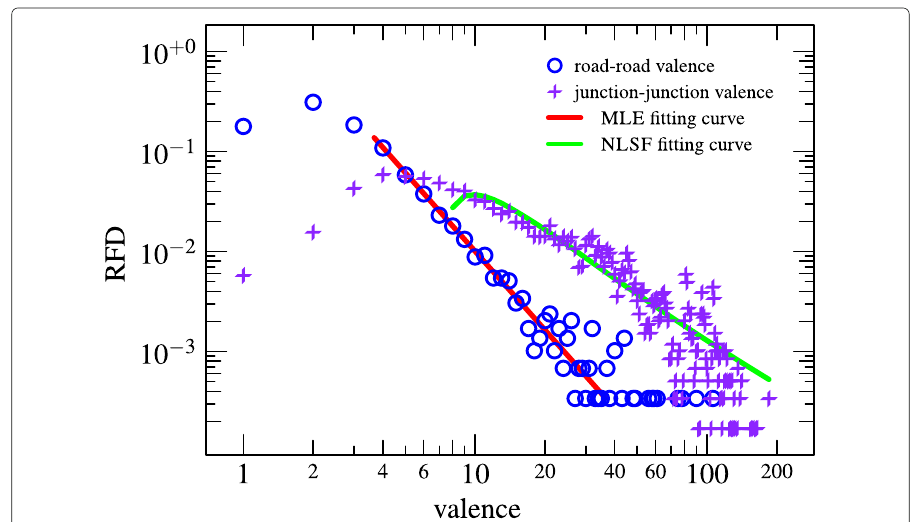
Fig. 4 Relative Frequency Distributions (RFD) for the urban street network of Central London: circles represent relative frequencies for the valences of the road-road topological network; crosses represent relative frequencies for the valences of the junction-junction topological network. The red fitted curve for the natural road statistics describes the Maximum Likelihood Estimate (MLE) for the discrete Pareto probability distribution (14a) estimated according to the state of the art (Clauset et al. 2009; Gillespie 2015) ( n r = 4, 2 λυ r = 2.610 ( 65 ) , n = 250000 samples, p -value = 0.933 ( 1 ) ). The green fitted curve for the junction statistics shows the best Nonlinear Least-Squares Fitting (NLSF) for the nonstandard discrete probability distribution (14b) with n r and 2 λυ r fixed to their respective MLE value (2 λυ j ≈ − 1.3); since fast evaluation of the normalizing function W has yet to be found, no MLE approach can be used for now. Having for junctions a number of vital connections υ j negative is interpreted as expressing a number of agent intraconnections for junctions relatively much smaller than the one for natural roads. The sharp downturn at a valence of 10 likely means that the model fails to catch what occurs when valences are small. In any case, a proper MLE remains to be performed for